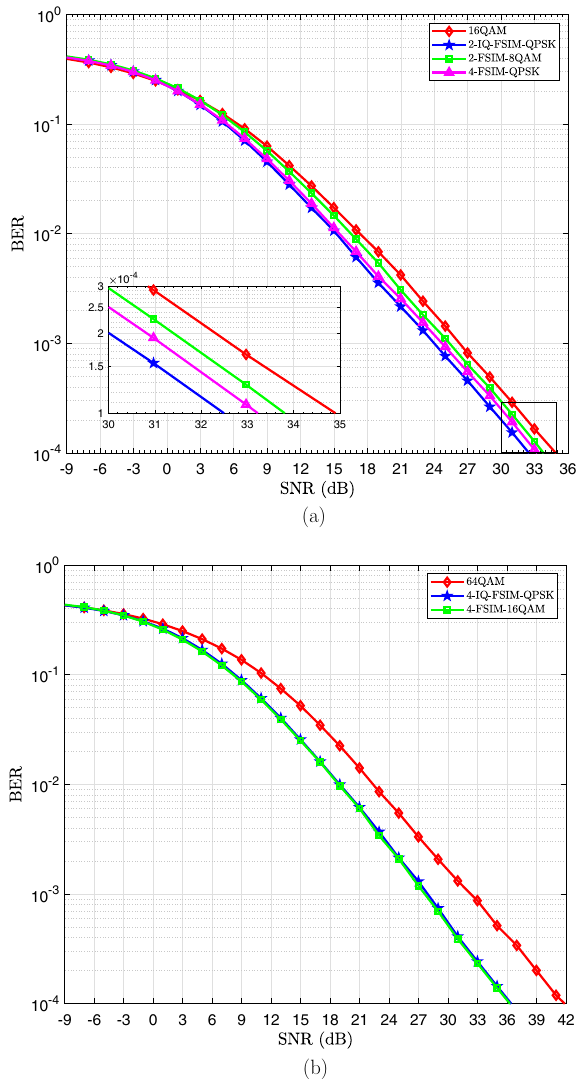
Fig. 14 BER performance for IQ-FSIM and different equivalent systems of same SE in a frequency-selective Rayleigh fading J = 4 : a SE = 4 bpcu, b SE = 6